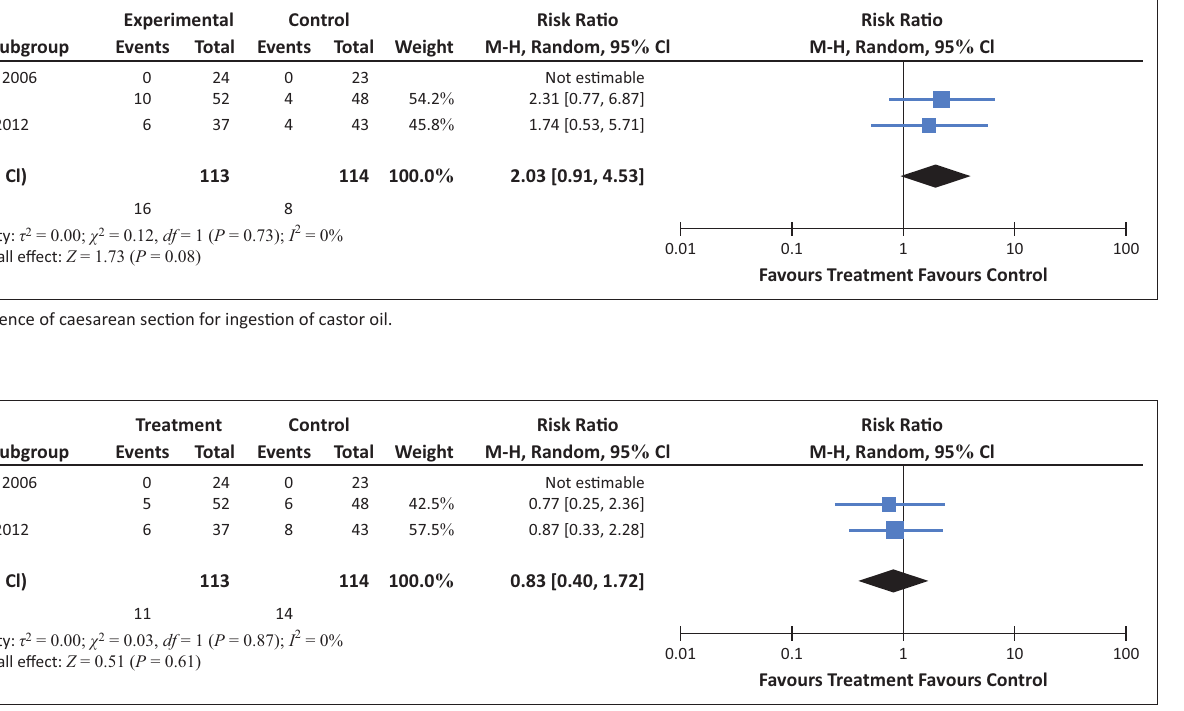
FIGURE 7: Incidence of meconium-stained amniotic